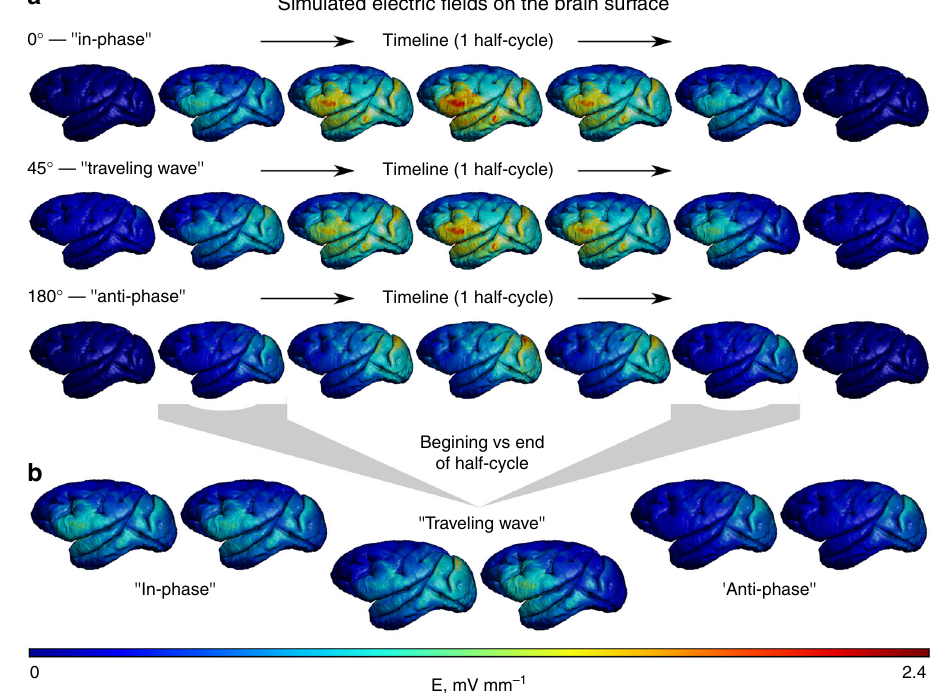
Fig. 7 Computer model of the electric fi eld on the gray matter surface during conventional stimulation with 0° and 180° phase difference and during “ traveling wave ” stimulation (45° phase difference). Panel a depicts the changes throughout the time (one half cycle of stimulation), and panel b highlights two time-points at the begging and end of half-cycle. See Supplementary Movies 5 – 7 and Supplementary Fig. 11 for more